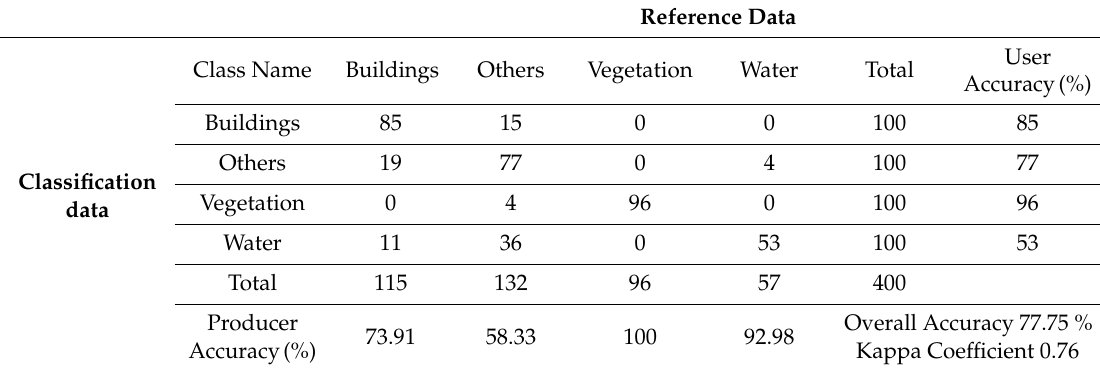
Table 1. Classification results obtained using Object Based Image Analysis (OBIA) technique.